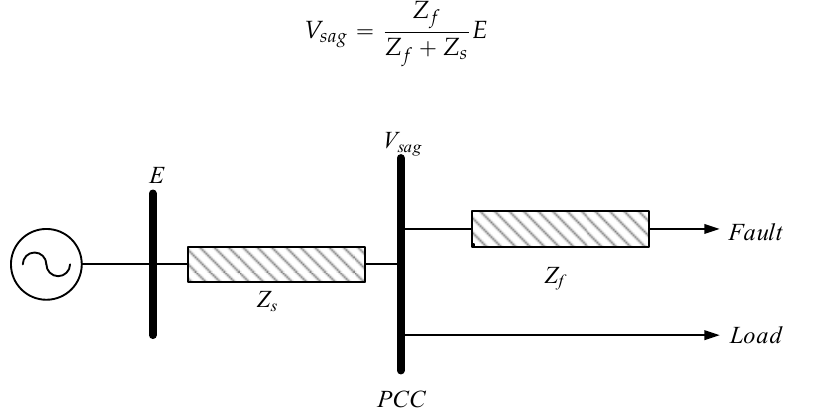
Figure 1. Voltage division model in measuring voltage sag. PCC: point of common coupling.